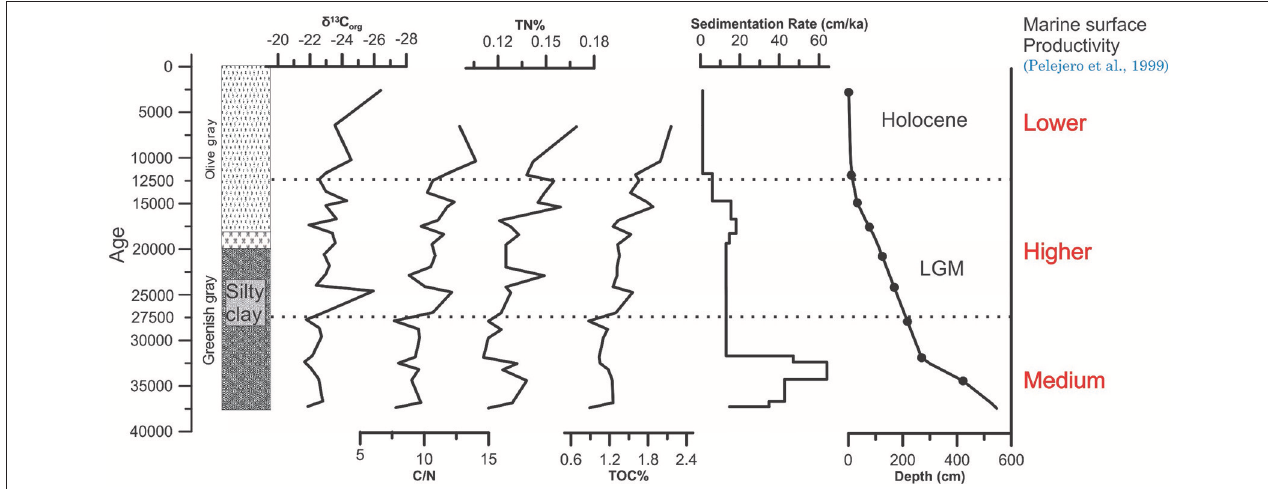
FIGURE 3 | Distribution of four geochemical proxies obtained from NS07-25 since 37ka B.P. Sedimentation rates, Lithology and the AMS14C-based age model in core were from Xiang et al.